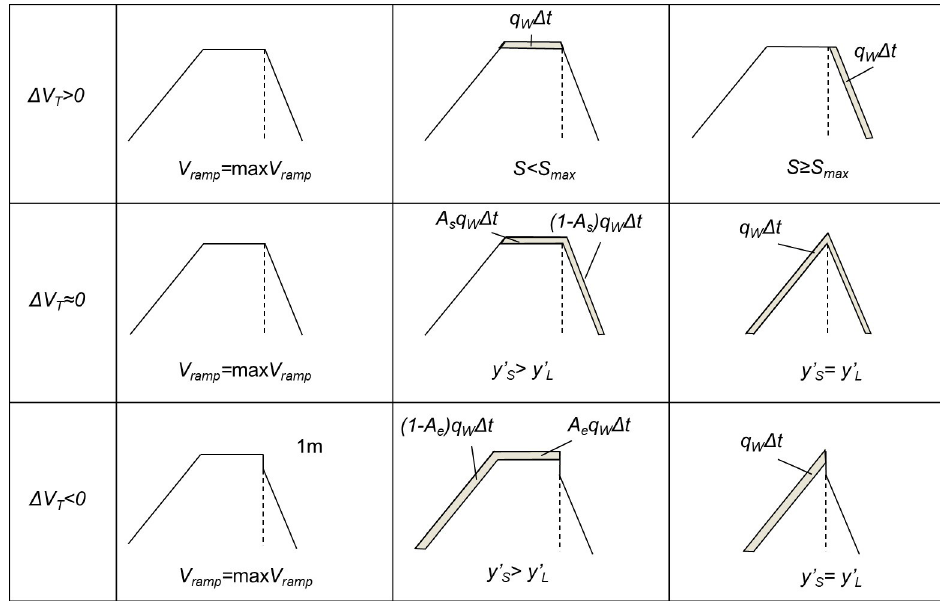
Fig 4. Sediment distribution scheme on a dune due to wind-blown